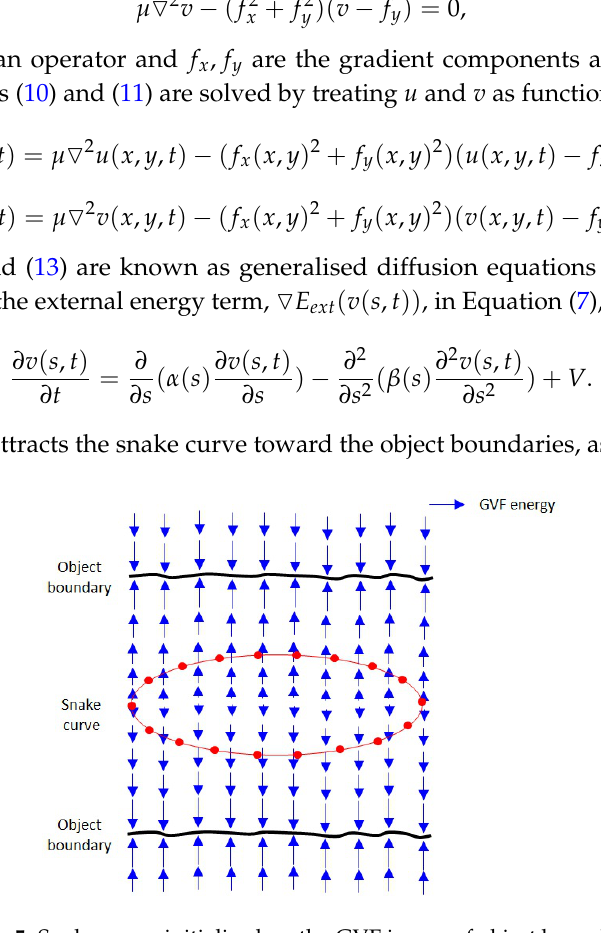
Figure 5. Snake curve initialised on the GVF image of object